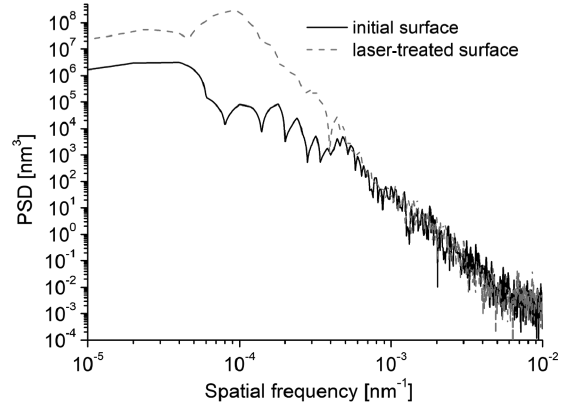
FIG. 5. (a) Power spectral density (PSD) of the initial surface in comparison to the laser-treated surface for F ¼ 0 . 68 J = cm 2 , N ¼ 160 . The data correspond to the AFM micrograph ( 50 × 50 μ m) presented in Fig.